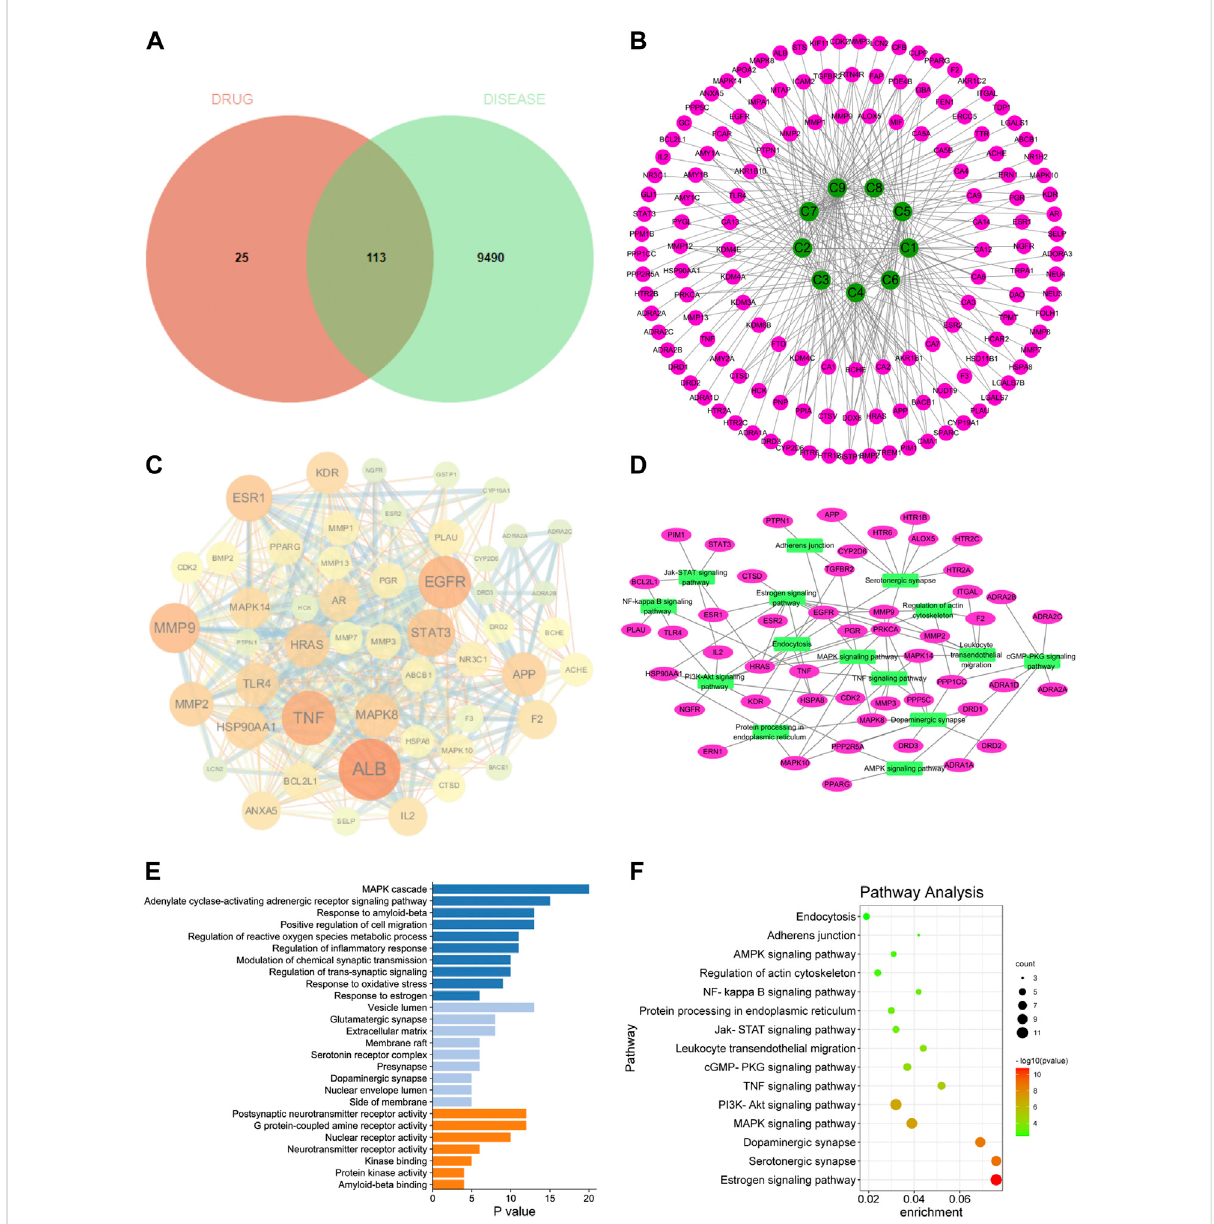
FIGURE 4 Network pharmacology analyze. (A) Venndiagram of SCPE-relatedtargets and AD-related targets; (B) Compound-target network of SCPEand AD. Green nodes represent candidate active compounds and pink nodes represent potential protein targets. Edges represent the interactions between them. (C) Protein-protein interaction (PPI) network of SCPE-related targets in AD. The size of the node is proportional to the degree of the node. (D) Target-pathway network of SCPE. Green nodes represent paths, pink nodes represent targets, and edges represent interactions between them. (E) List of Gene Ontology (GO) results in relation to the potential targets of SCPE.The fi rst 26 GO terms were identi fi ed based on p < 0.01. (F) Kyoto Encyclopedia of Genes and Genomes (KEGG) pathway enrichment results in relation to the potential targets of SCPE.The top 15 pathways were identi fi ed based on p <